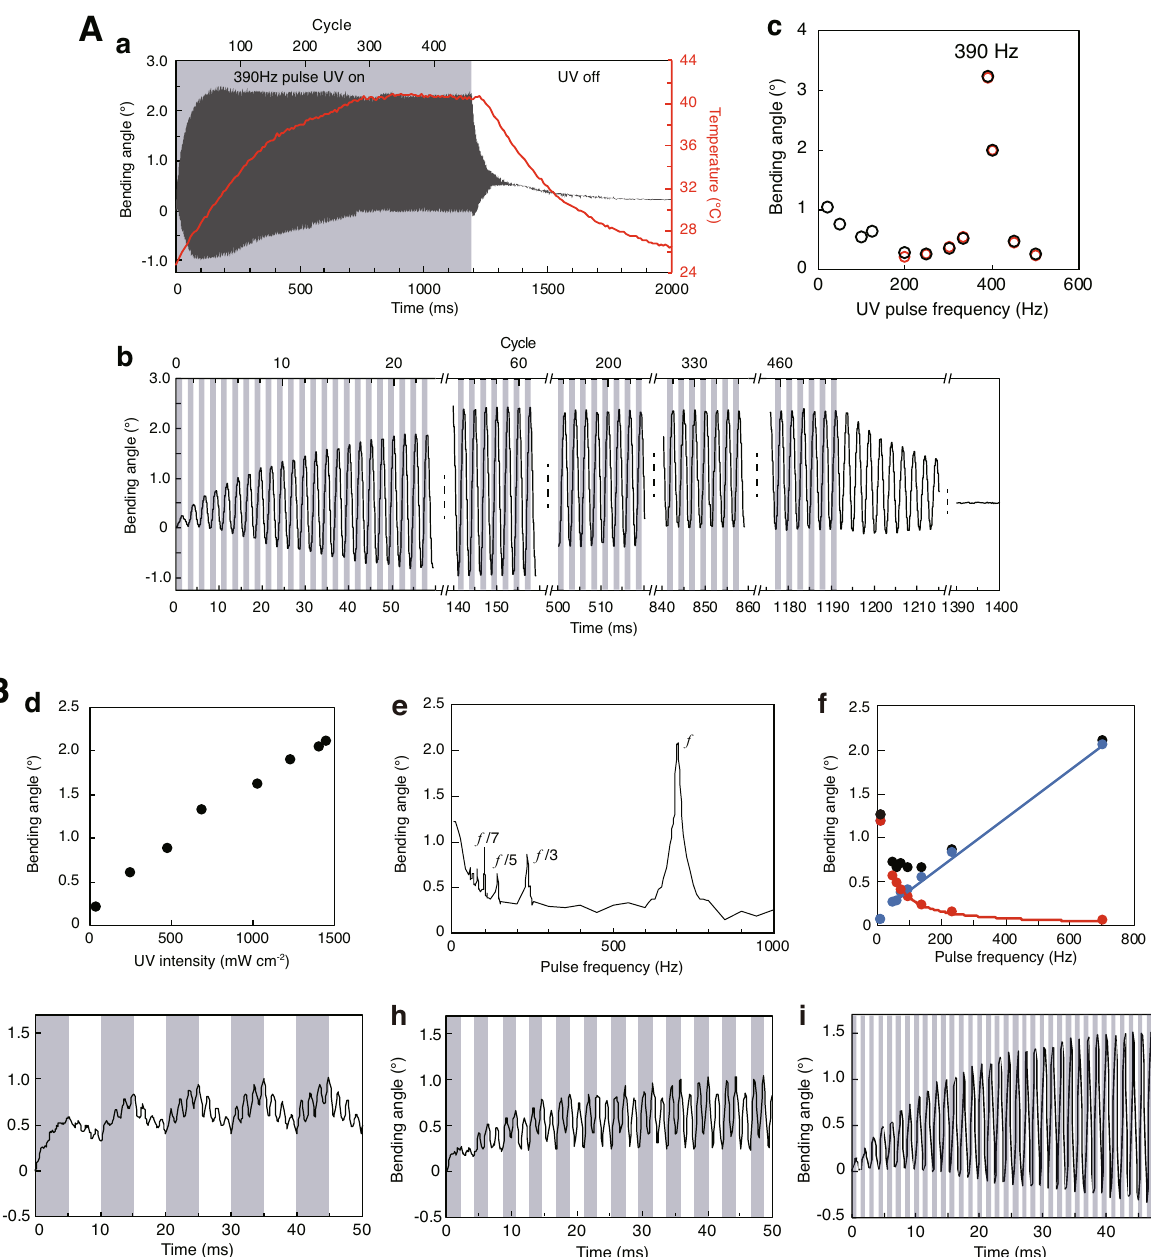
e UV pulse frequency (5 – 1000Hz) relationship with the maximum bending angle. f Pulse frequency dependence of the measured bending angle (black), the photo- thermally driven bending angle (red) and the natural vibration (blue) at the odd fractions of the natural frequency (702Hz). g – i Time pro fi les of high-speed bend- inguponpulsedUVirradiationofoddfractionsofthenaturalfrequency: g 99( f /7), h 233 ( f /3) and i 702Hz ( f